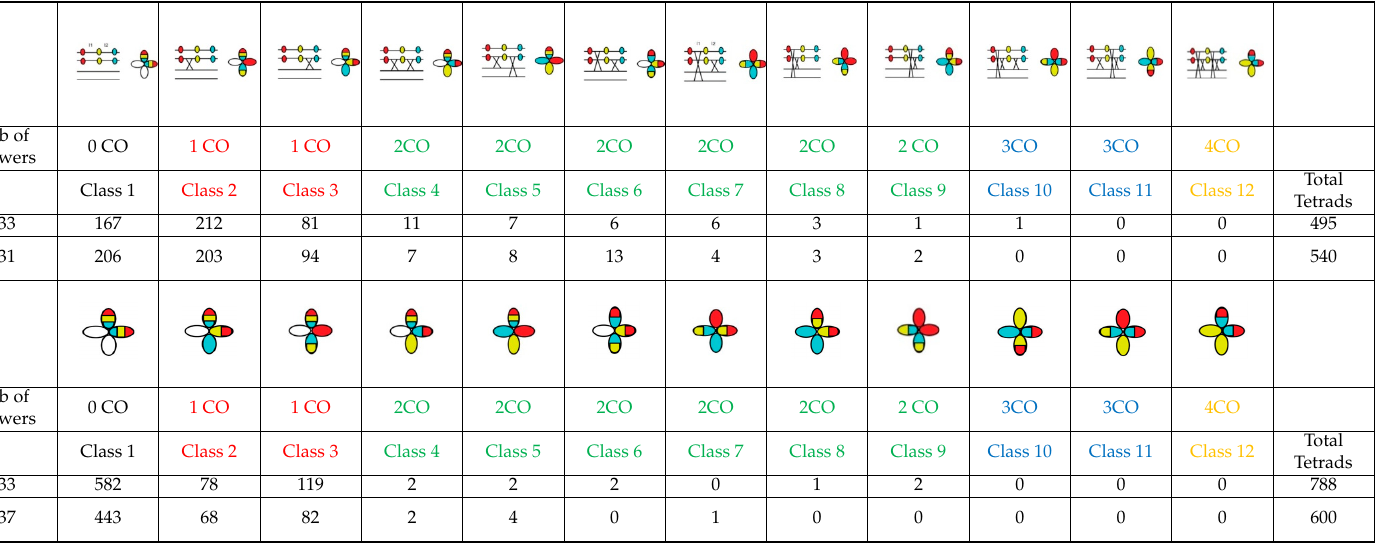
Table 1. Classification and counting of pollen tetrads in control and inoculated plants of I5ab and I5cd lines. For each FTL line containing the three markers (cyan, red and blue), the different possibilities of markers distribution among the four chromatids and the corresponding distribution in the tetrad have been represented as drawings above each column, according to Berchowitz and Copenhaver’s nomenclature [30]. For each condition (control or inoculated), since a similar pattern of tetrad distribution was observed for the two plants studied, revealing no bias related to a single plant, the observed total number of each type of tetrad is given for the two plants corresponding, either to the interval I5ab (up) or to I5cd (down). Similarly, the total number of flowers and tetrads from the two control and the two inoculated plants analyzed in this study are also mentioned for both I5ab and I5cd lines.